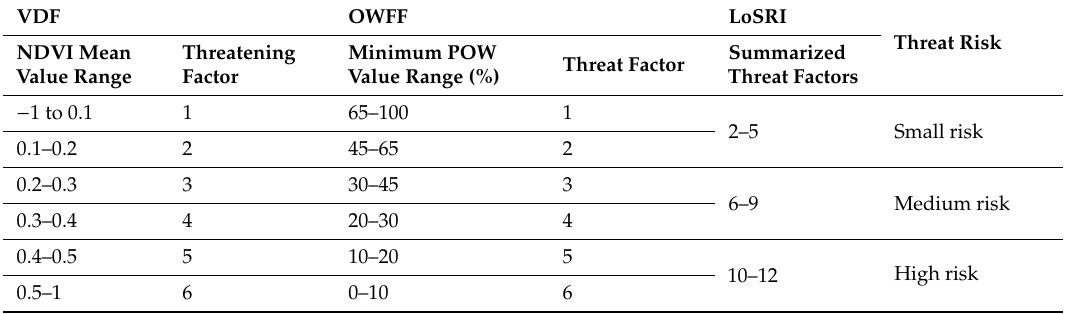
Table 3. Threshold values for threat factors (VDF: Vegetation Density Factor; OWFF: Open Water Fraction Factor; LoSRI: Level of Sedimentation Risk Index; NDVI: Normalized Di ff erence Vegetation Index; POW: Percentage of Open